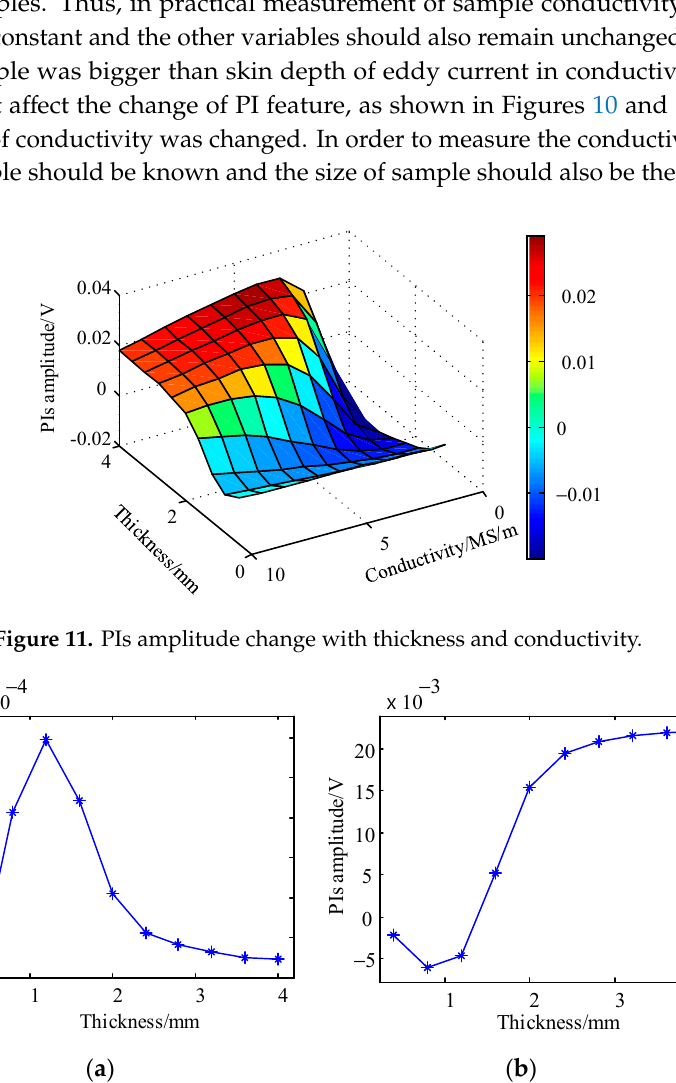
Figure 11. PIs amplitude change with thickness and conductivity.